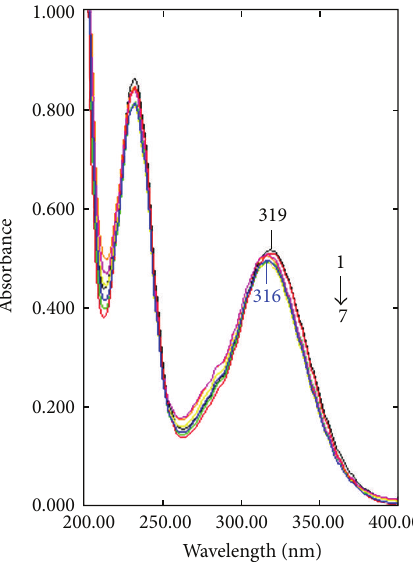
Figure1:UV-visabsorptionspectraofbenzoylmetronidazole( 5.7× 10 −5 M) at various concentrations of 𝛽 -CD at 298 K: (1) no 𝛽 -CD, (2)